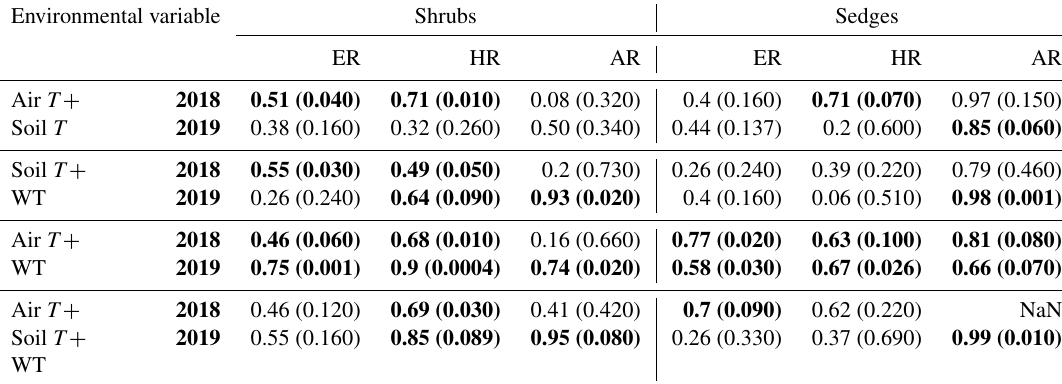
Table 4. Coefficient of determination ( R 2 ) for multiple regressions between respiration (ER, AR, and HR) and environmental variables in 2018 and 2019 with p values in brackets and significant relationships ( p< 0 . 1) in bold. WT is water table depth, air T is air temperature measured at the flux tower, and soil T is soil temperature at 10cm depth. “NaN” refers to there not being enough data points to determine